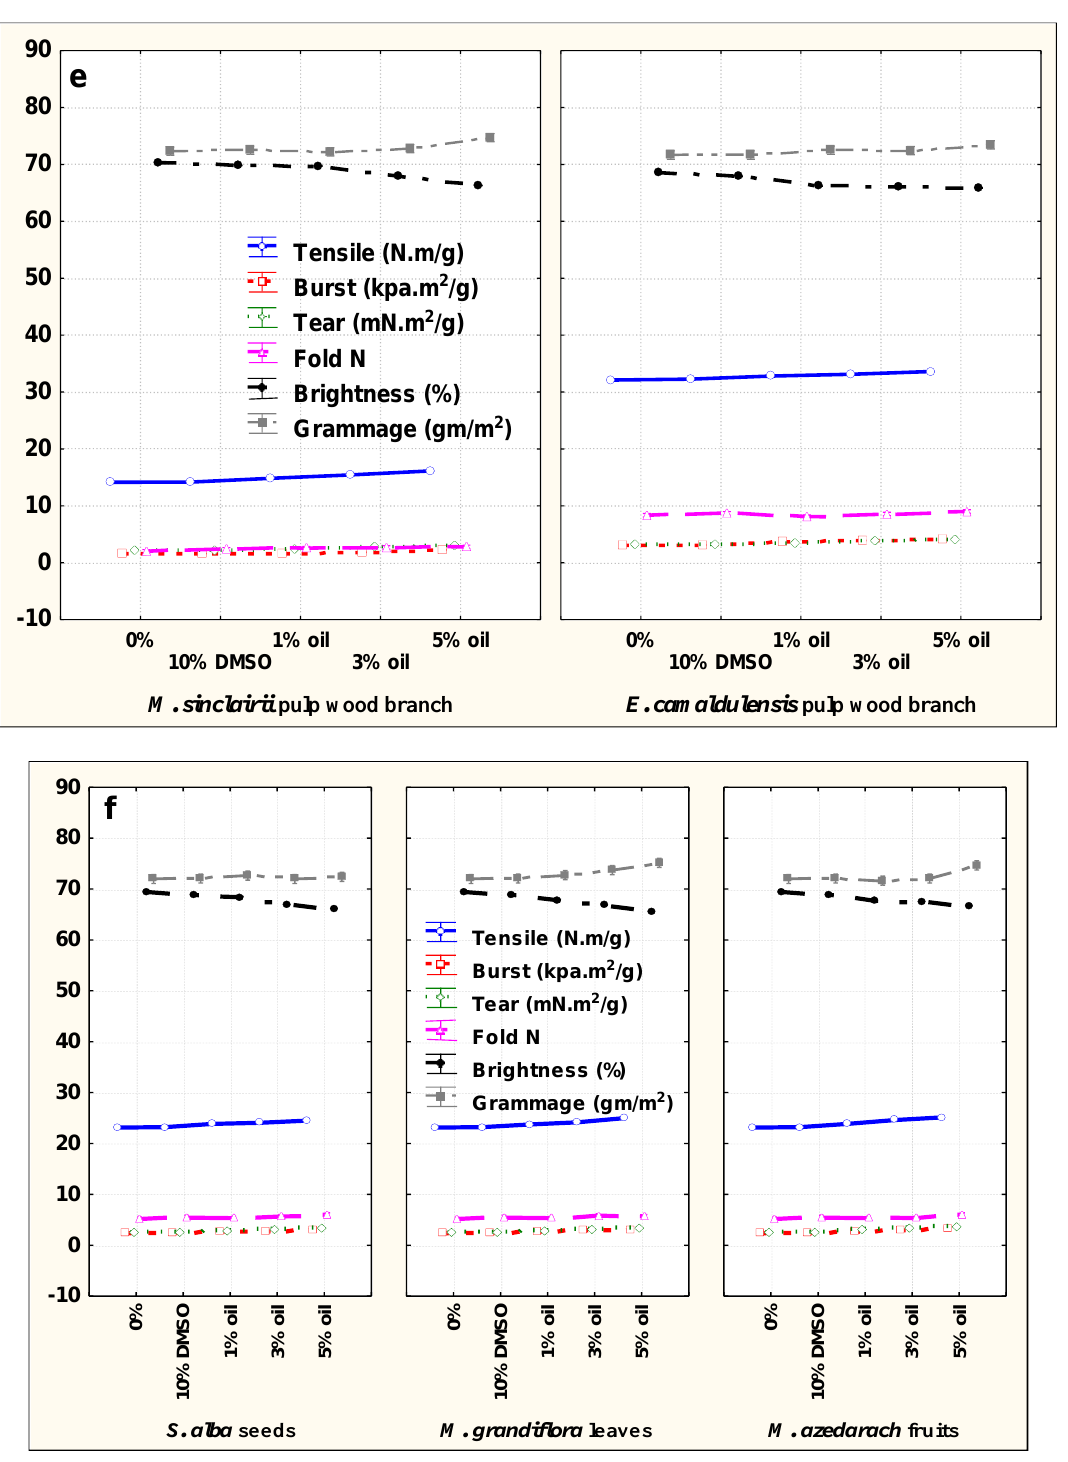
Figure 1. Effects of pulp source, HeOE source, and HeOE concentration on the mechanical and optical properties of the produced paper sheets. ( a ): Pulp source; ( b ): HeOE source; ( c ): HeOE concentrations; ( d ): interaction between pulp source and HeOE source; ( e ): interaction between pulp source and HeOE concentrations; ( f ): interaction between HeOE source and HeOE concentrations.